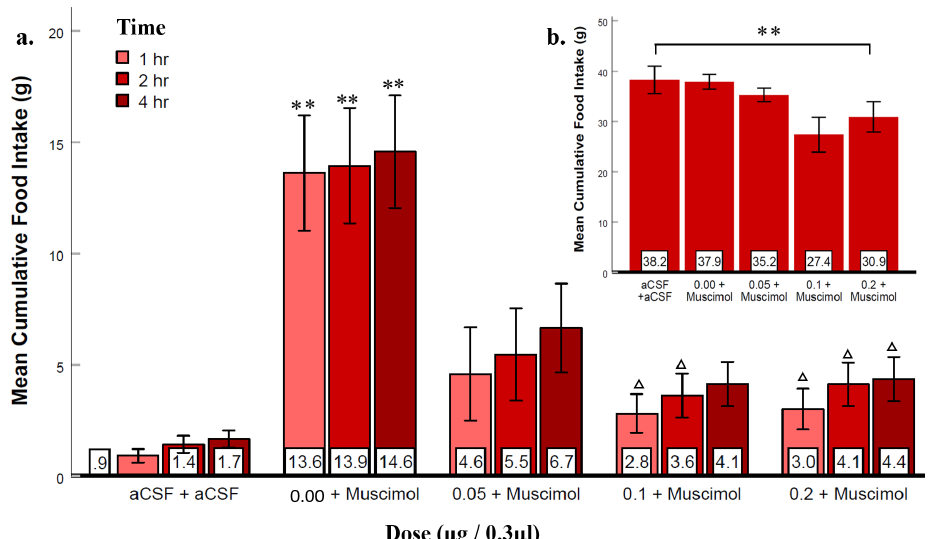
Figure 4. Pretreatment with picrotoxin suppressed the muscimol-induced feeding response. Error bars ± SEM; n = 11; mean values are shown at the bottom of each bar. ( a ) ** indicates significant dif- ferences compared to the aCSF group at matched times at p < 0.01. ∆ indicates significant differences compared to the aCSF + muscimol group at matched times at p < 0.05. ( b ) Picrotoxin suppressed 24-h food intake by one-way repeated measures ANOVA, showing a significant combined effect of dose. ** indicates significant main effects at p <